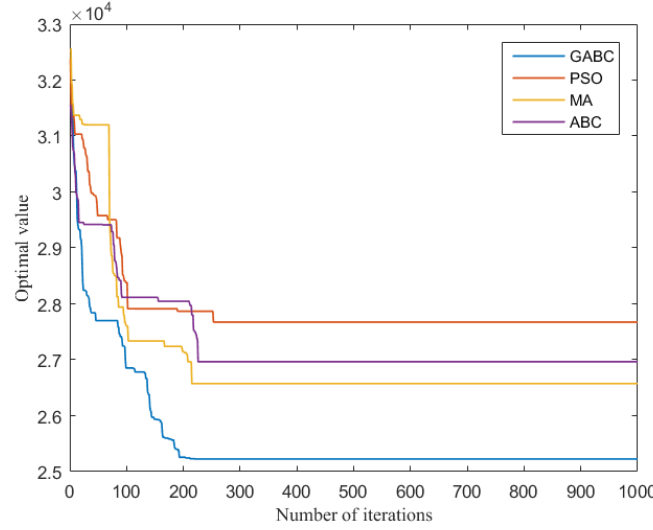
Figure 22. Number of iterations.